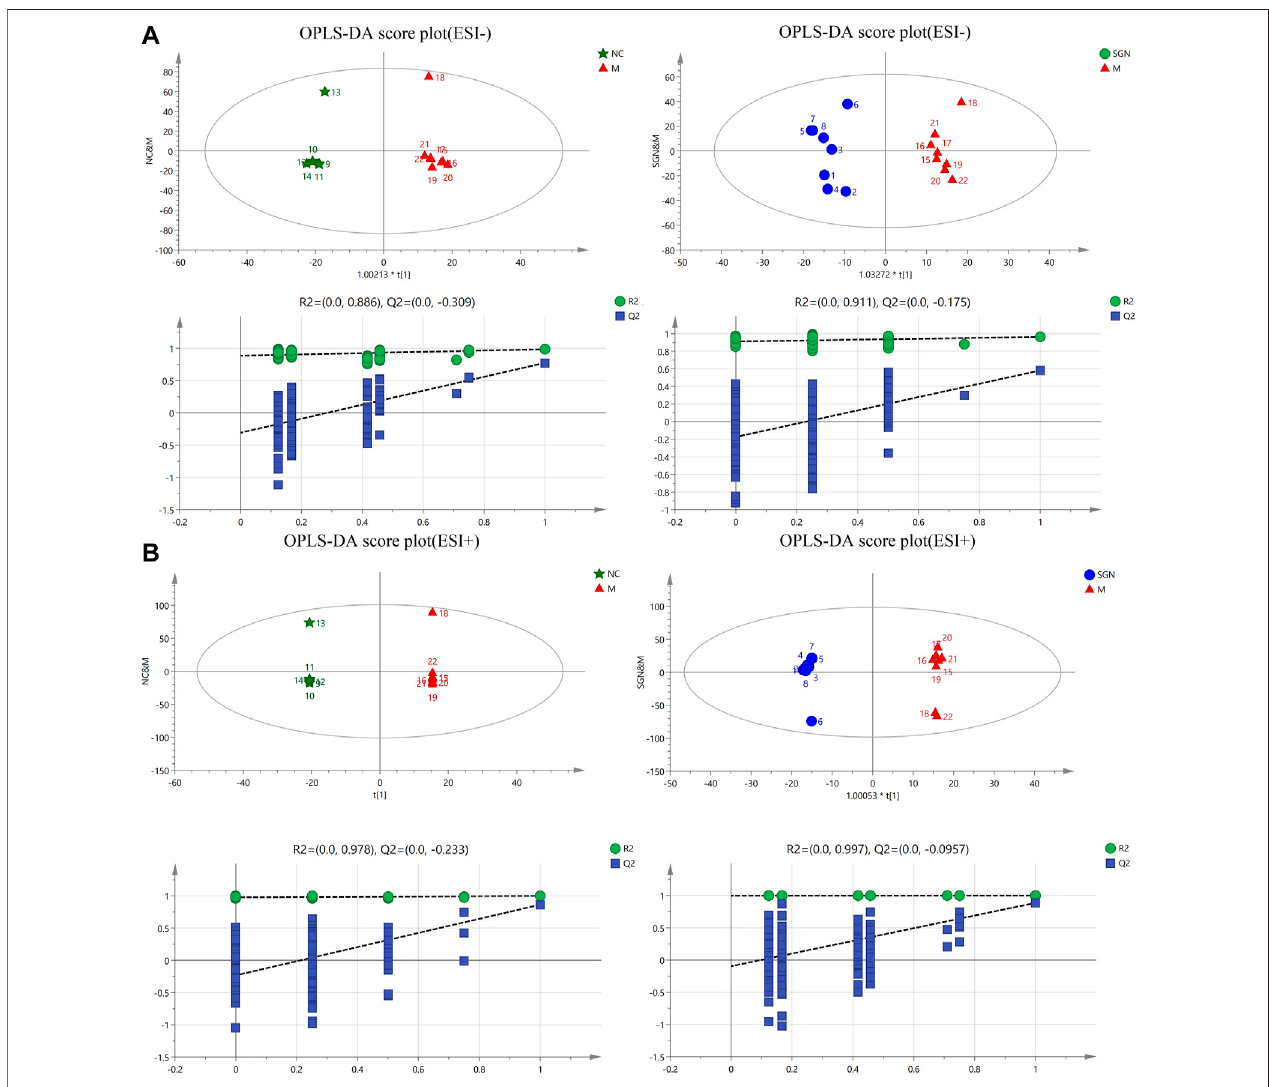
FIGURE 4 | OPLS-DA score plots and corresponding model validation plot of rat serum samples in positive and negative modes.